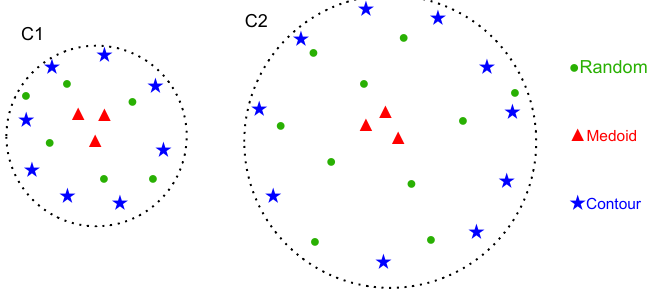
Figure 2. Types of sampling (random, medoid and contour). C1 (cluster 1) and C2 (cluster